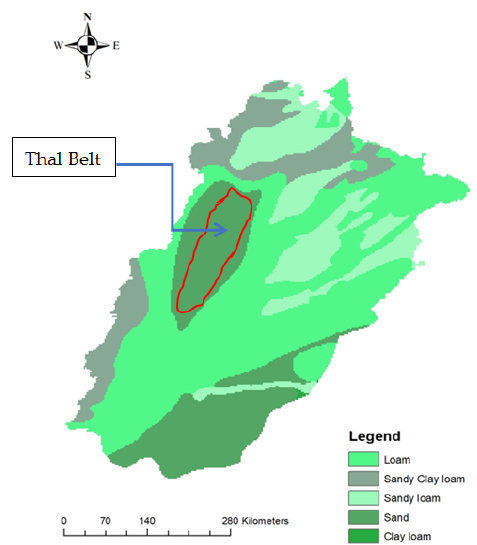
Figure 7. Soil texture classification for Punjab, Pakistan, extracted from Soil Map of the World [50].